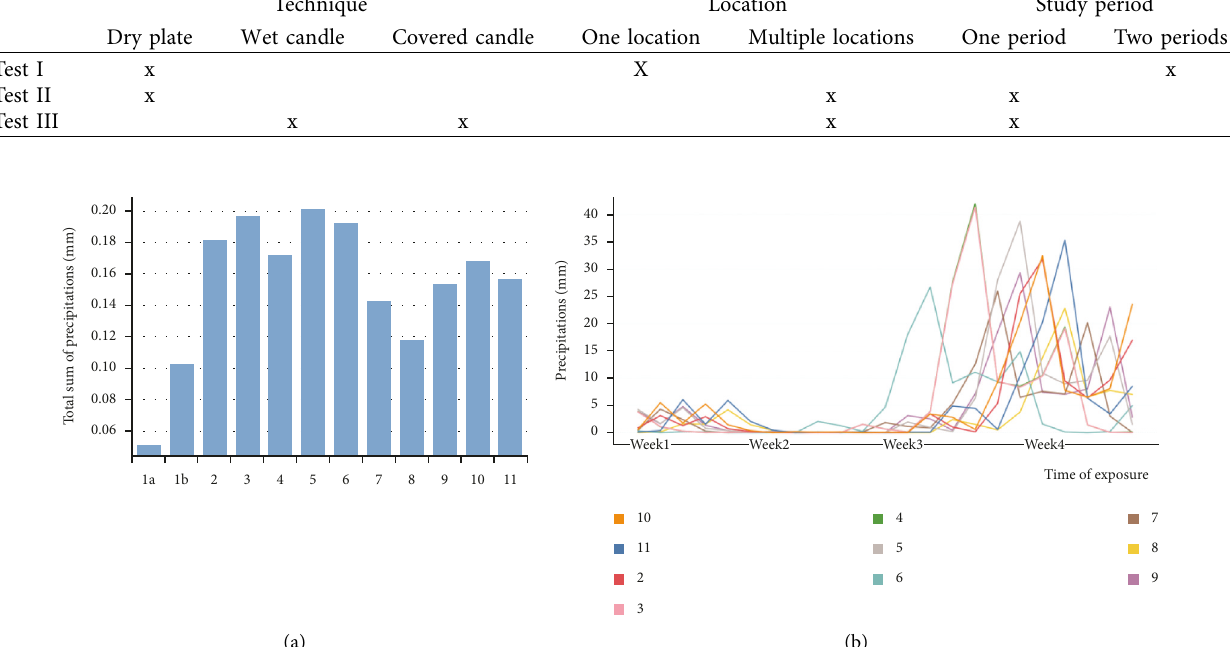
Figure 5: (a) Cumulative rainfall during the study periods at each location. (b) Distribution of rainfall by location over time.